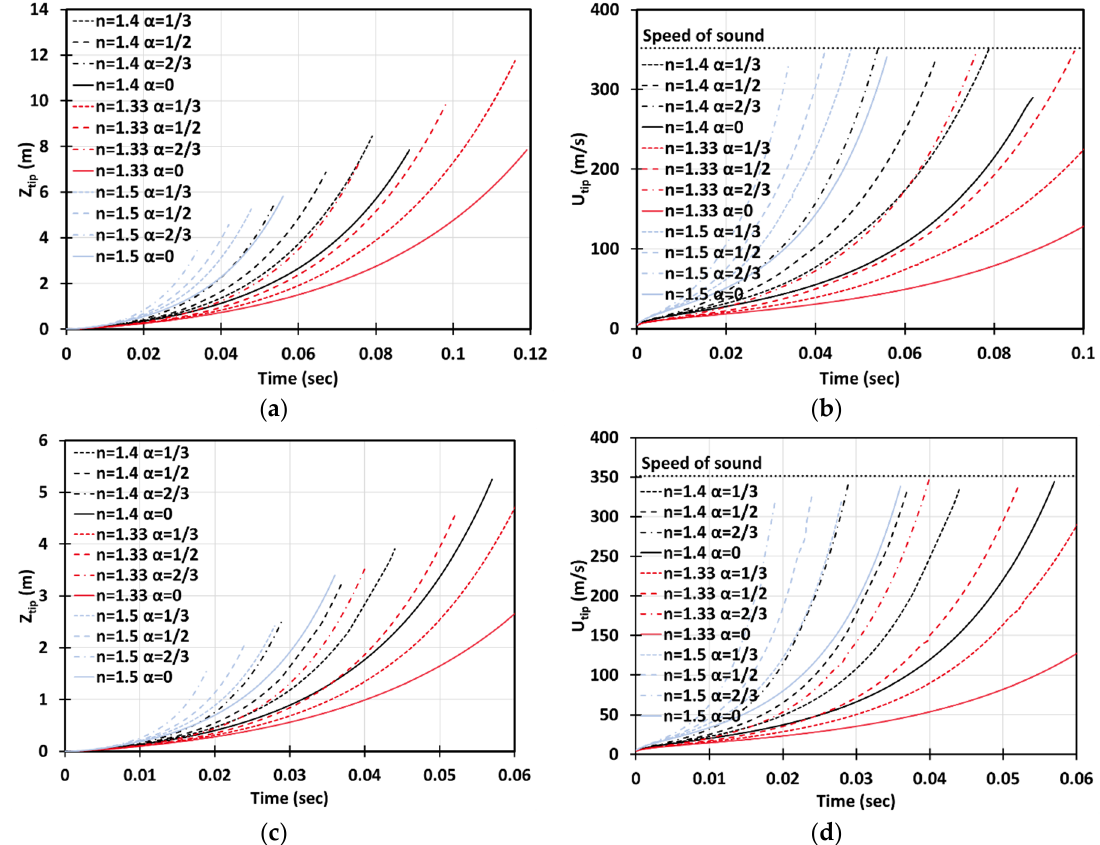
Figure 5. Time evolution of the flame tip position Z tip ( a , c ) and velocity U tip ( b , d ) in a 2D ( a , b ) and cylindrical-axisymmetric ( c , d ) geometry for stoichiometric CH 4 -air burning with various blockage ratios α = 0,1/3,1/2,2/3 and various power factors n = 1.33, 1.4, 1.5.